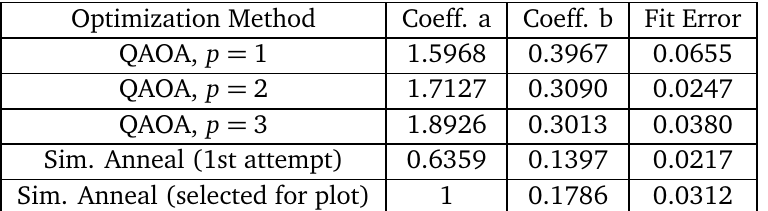
Table 2: Curve fit details for various QAOA depths from Figure 4 where the curve modeled is of the type: 1 − ( 1 − a / 2 bn ) k at k = 1 for QAOA and k = 10 for simulated annealing (and extrapolated to k = 10 and k = 1 respectively for plotting purposes). All numerical values are rounded to a precision of 4 decimal